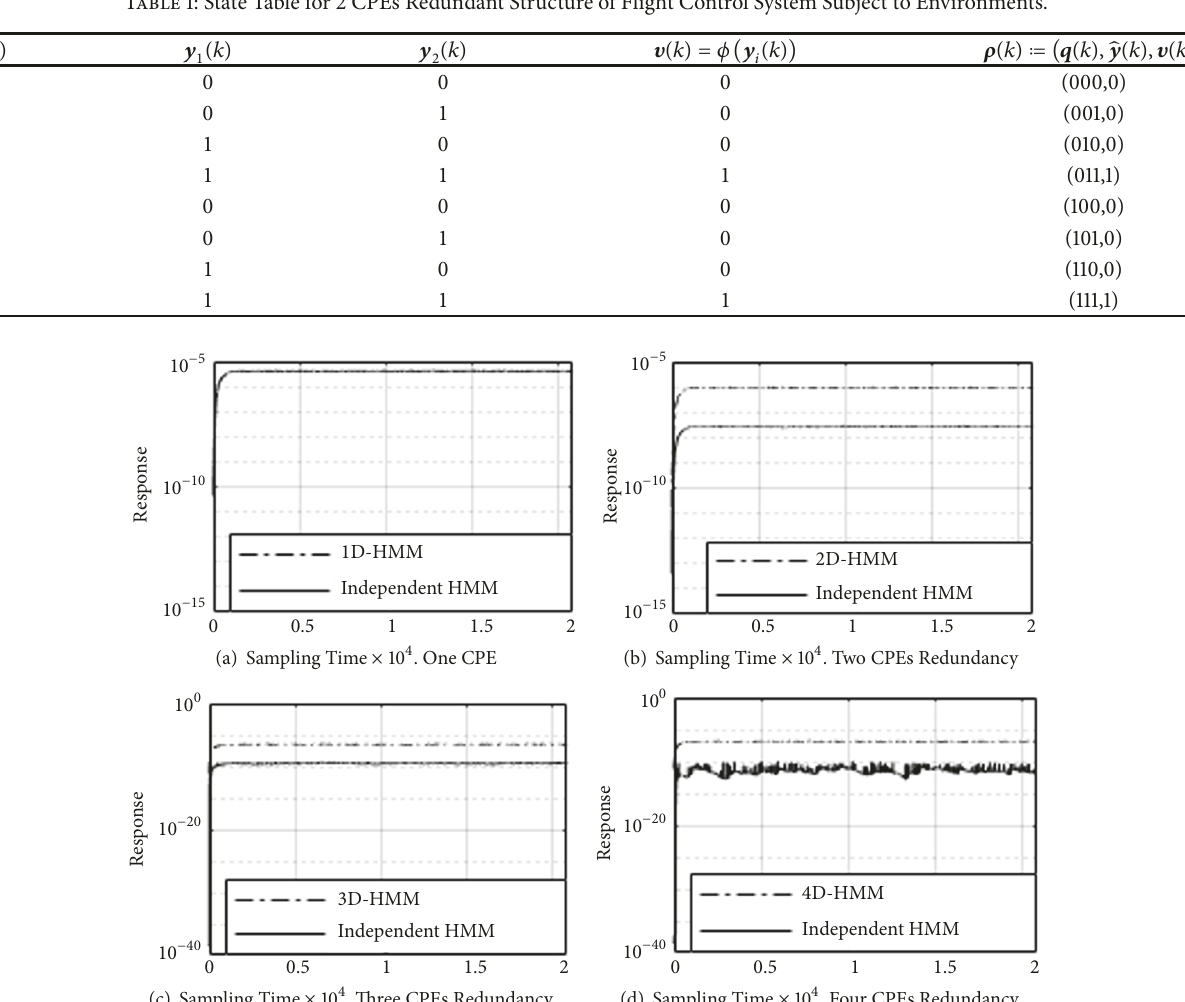
Figure 6: Comparison of the performance degradation response between the MDHMM model and the corresponding independent HMM model for four redundant